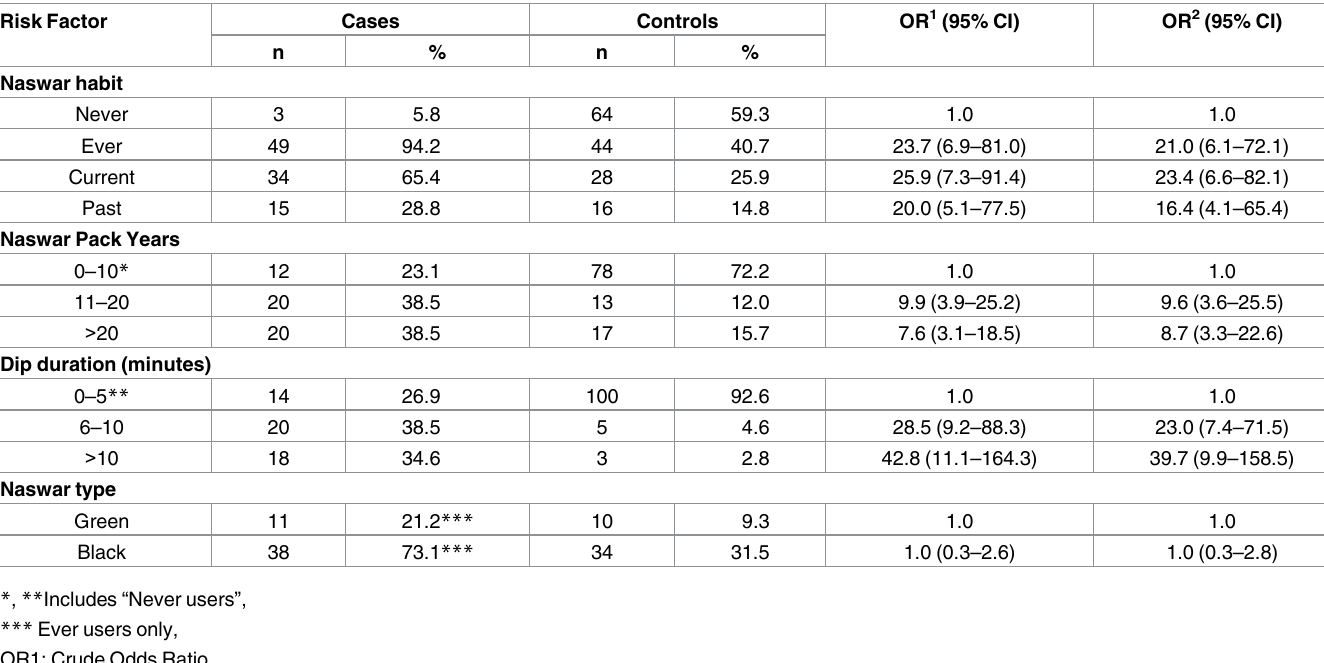
Table 4. Naswar use and the risk of oral cancer among men (52 cases,108 controls) in Khyber Pakhtunkhwa, Pakistan, crude and adjusted risk estimatesfrom simple logistic regression. Risk Factor